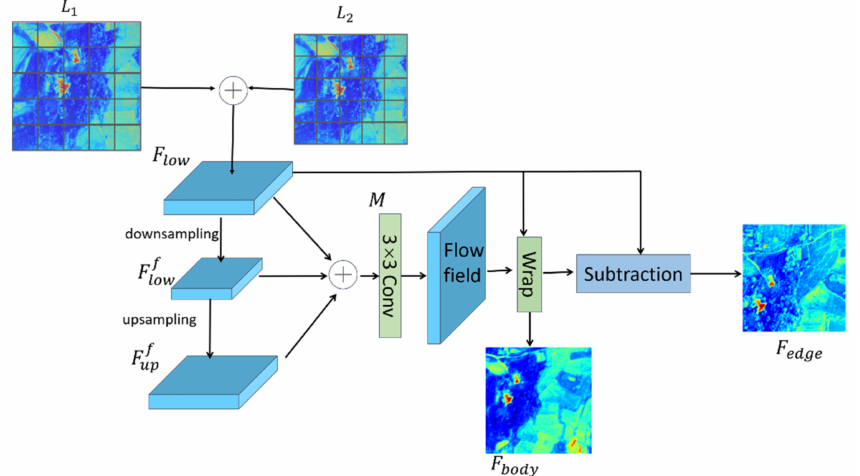
Figure 4. Main structure of boundary and body separation. We upsampled features L 2 and combined it with features L 1 to obtain low-level features F low . F f is obtained by downsampling with F low . low F f up is obtained by upsampling with F f . F edge represents the edge features. F body represents the low body